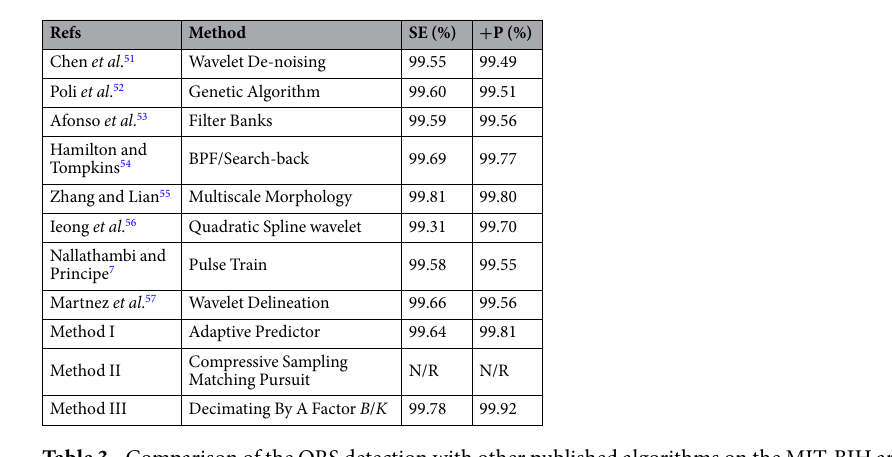
Table 3. Comparison of the QRS detection with other published algorithms on the MIT-BIH arrhythmia database. SE stands for sensitivity, while + P stands for positive predictivity. N/R stands for Not